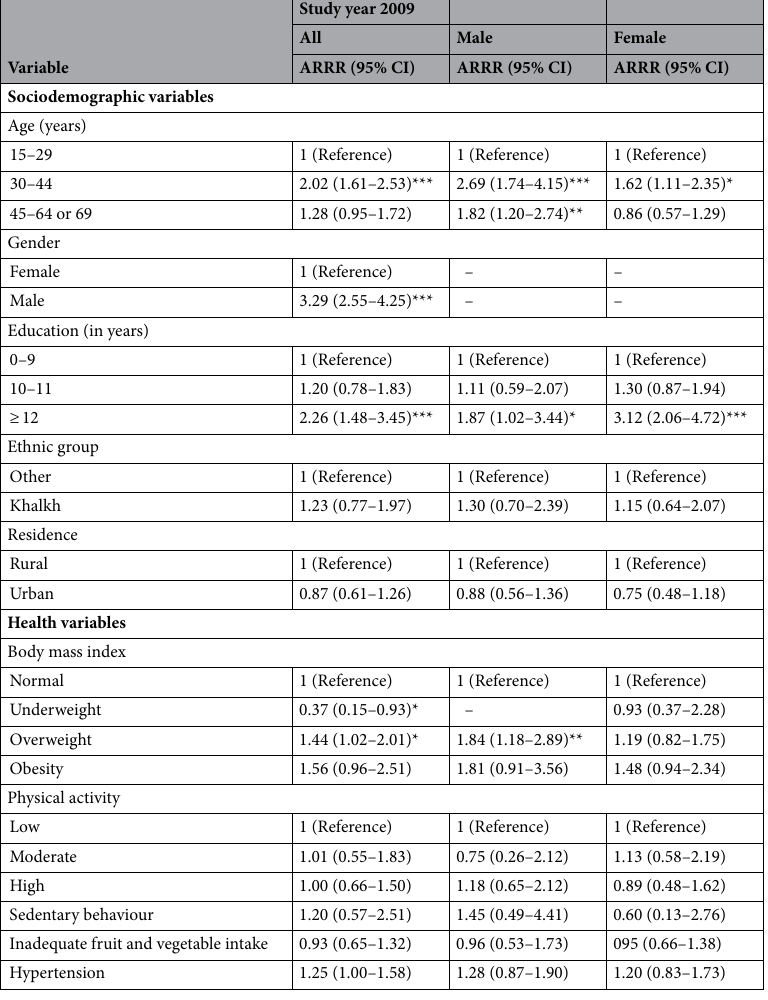
Table 12. Associations with current heavy drinking only (with non-current tobacco and non-current heavy drinking as reference category) among 15 years and older individuals in Mongolia, 2009. *** p <